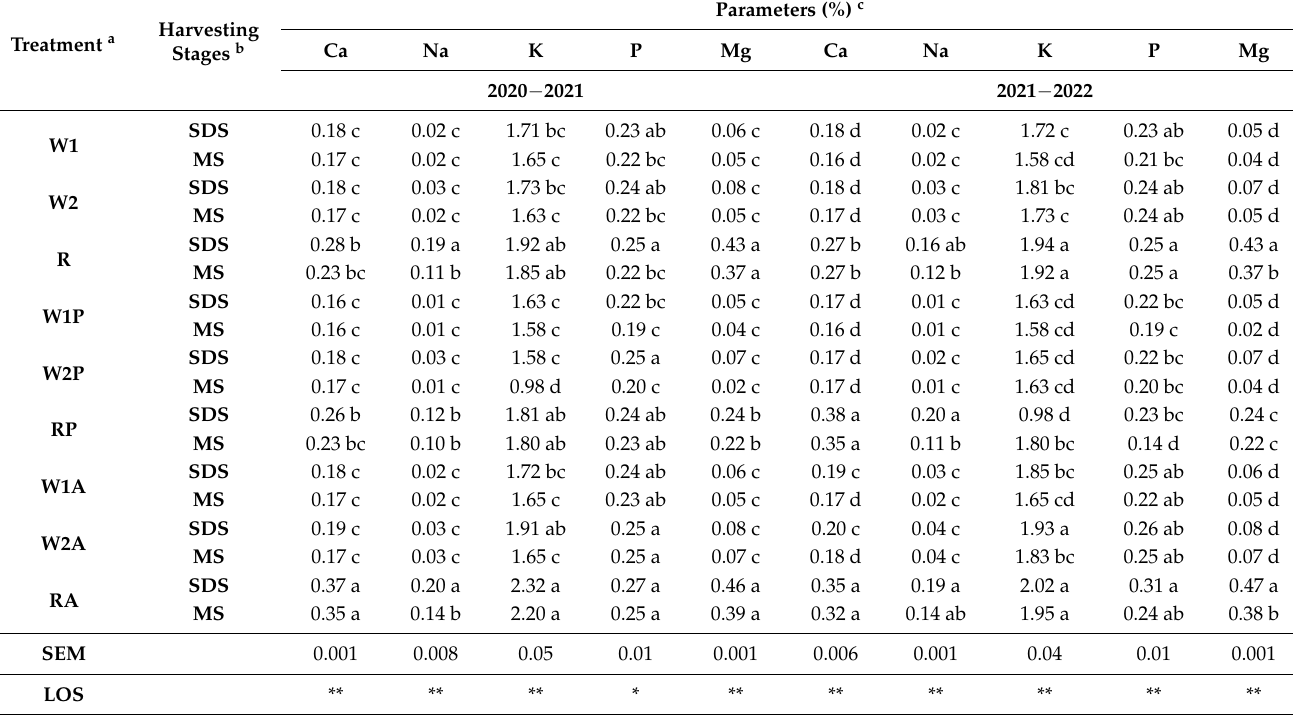
Table 6. Mineral compositions of cereal monocropping and cereal–legume mixed